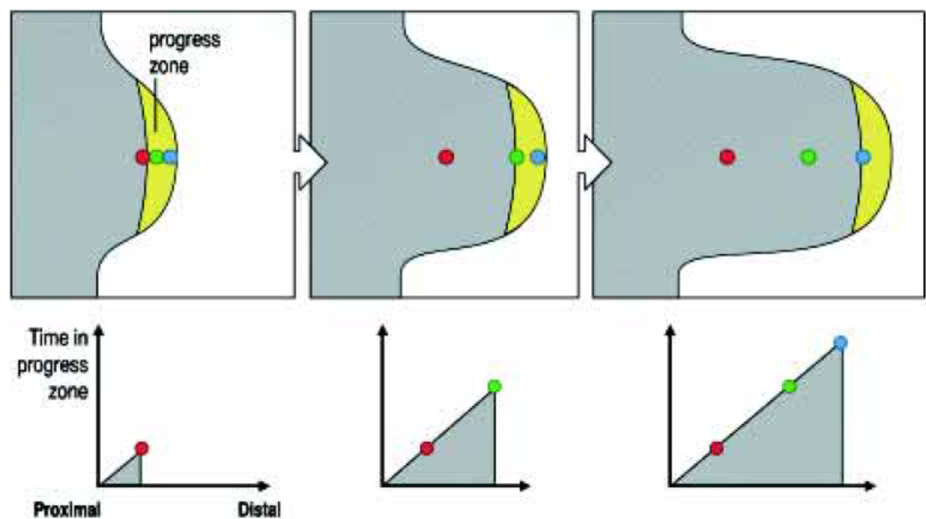
Figure 1. The Progress Zone Model. A cell’s proximodistal (PD) positional value may depend on the time it spends in the Progress Zone. Cells continually leave this zone at the tip of the limb under the apical ectodermal ridge. Cells that leave early form proximal structures while cells that leave last form the (distal) tips of the digits. Reprinted with kind permission from UPV/EHU Press from the source: Wolpert, L. (2002). The progress zone model for specifying positional information. Int. J. Dev. Biol . 46: 869–870 [5].